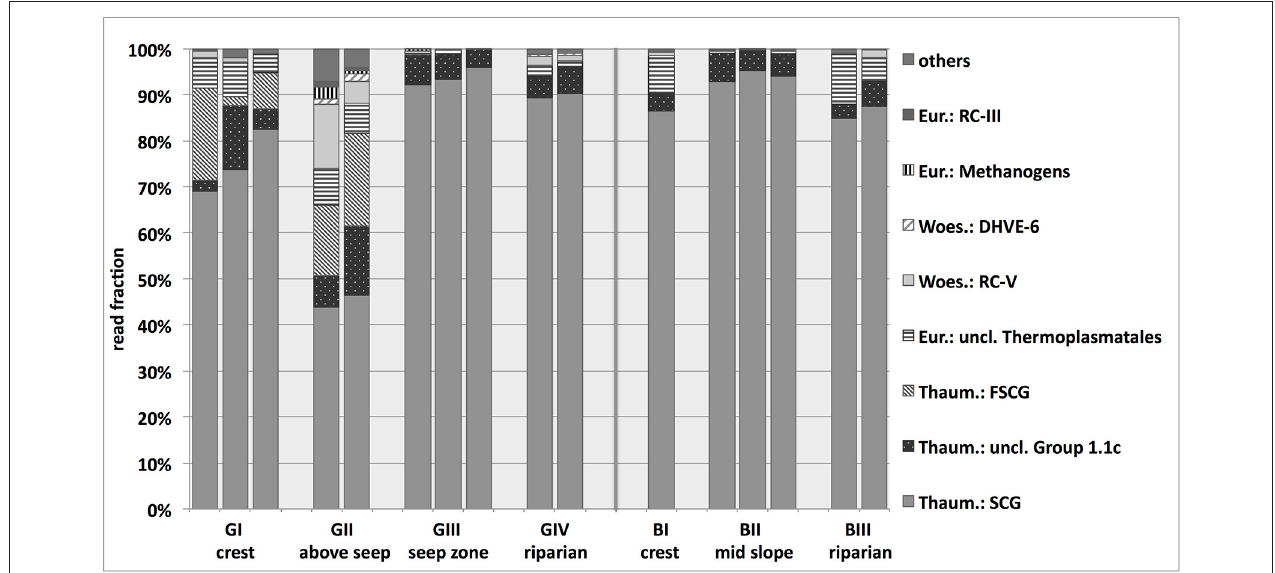
FIGURE 5 | Classification of sequences obtained from archaeal 16S rRNA gene-targeted Illumina sequencing of savanna soil samples taken from 5 cm depth at different locations along the granitic (GI-GIV) and the basaltic (BI-BIII) catena. Eur, Euryarchaeota; RC, Rice Cluster; Woes, Woesearchaeota; DHVE, Deep Sea Hydrothermal Vent Euryarchaeota Group; Thaum, Thaumarchaeota; uncl, unclassified; (F)SCG, (Forest) Soil Creanarchaeota Group. For some samples, replicates had to be excluded from further analysis of the normalized data set due to low read numbers. Results based on the non-normalized sequence data, including more soil replicates, are presented in Supplementary Figure